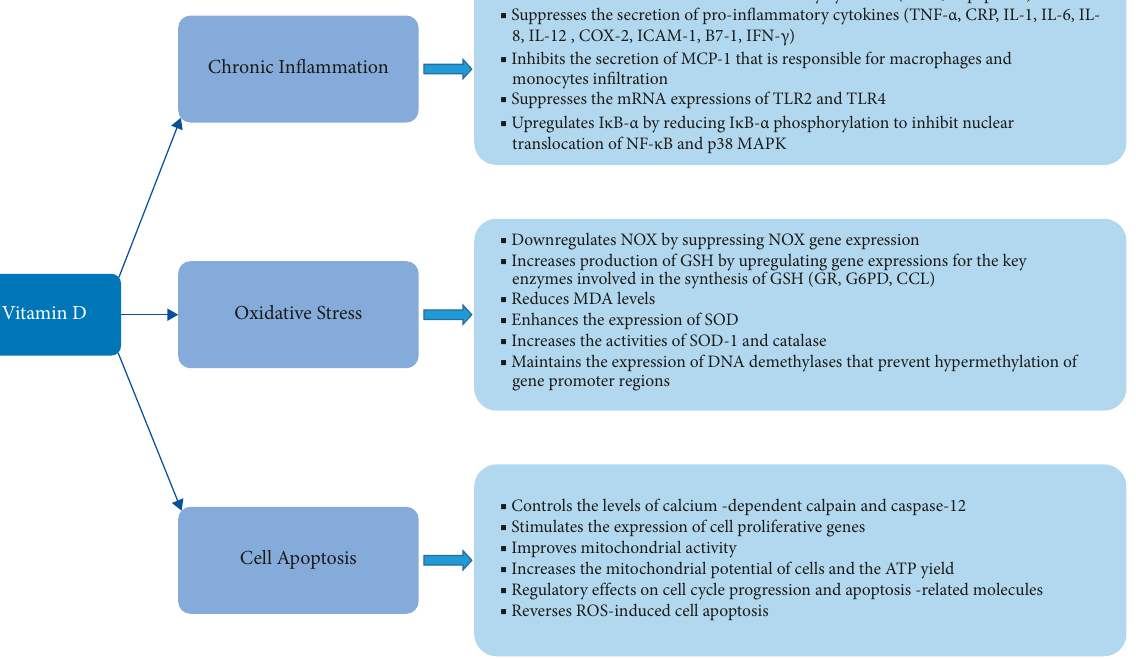
Figure 4: The roles of vitamin D in chronic inflammation, oxidative stress, and cell